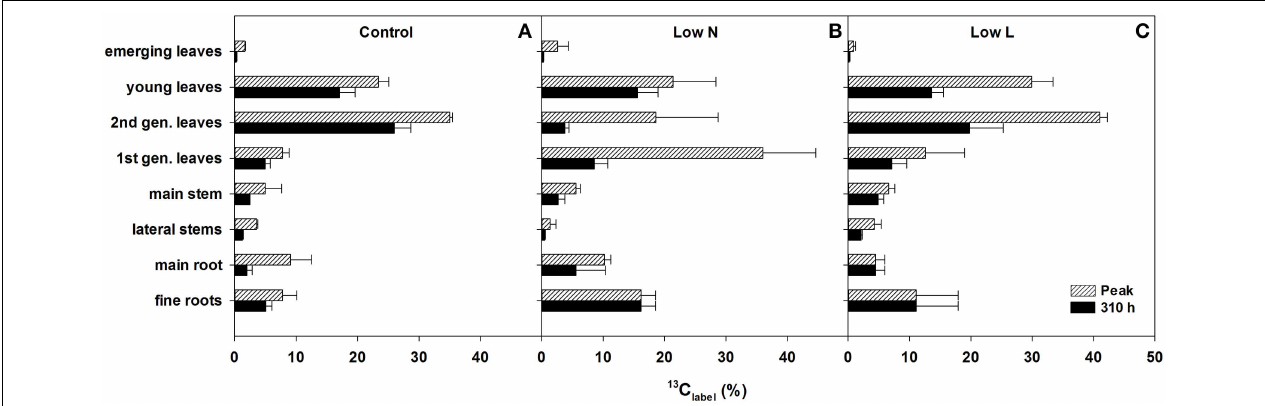
Low N (B) , and Low L (C) treatment are shown ( n = 2 ± SE). In case of equal length of the bars the highest value of the chase period was measured at the last harvest (310h).